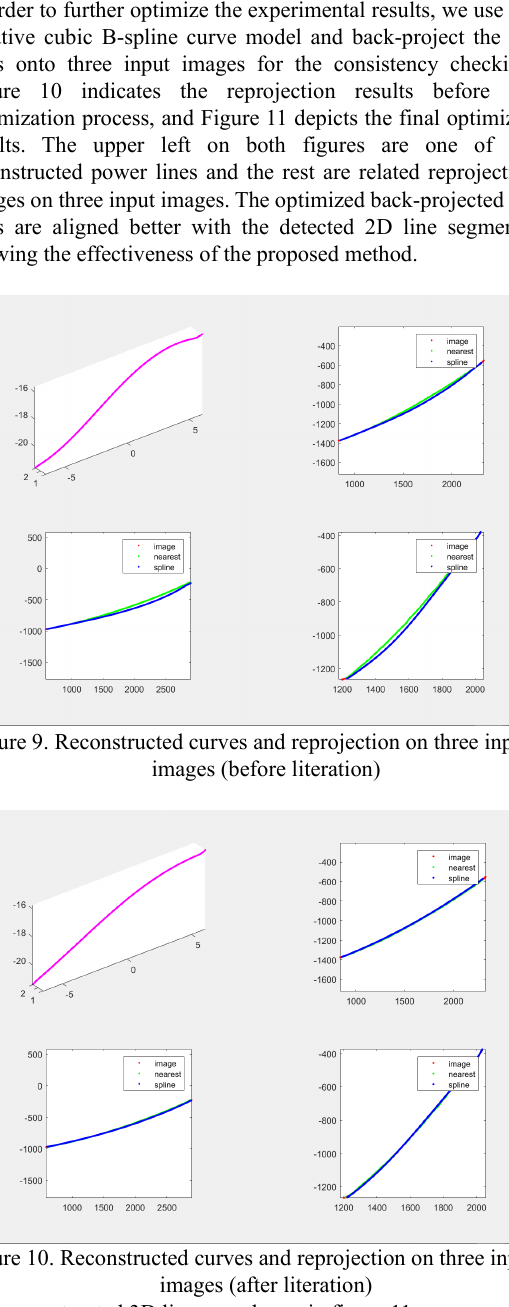
Figure 10. Reconstructed curves and reprojection on three input images (after literation) The reconstructed 3D lines are shown in figure